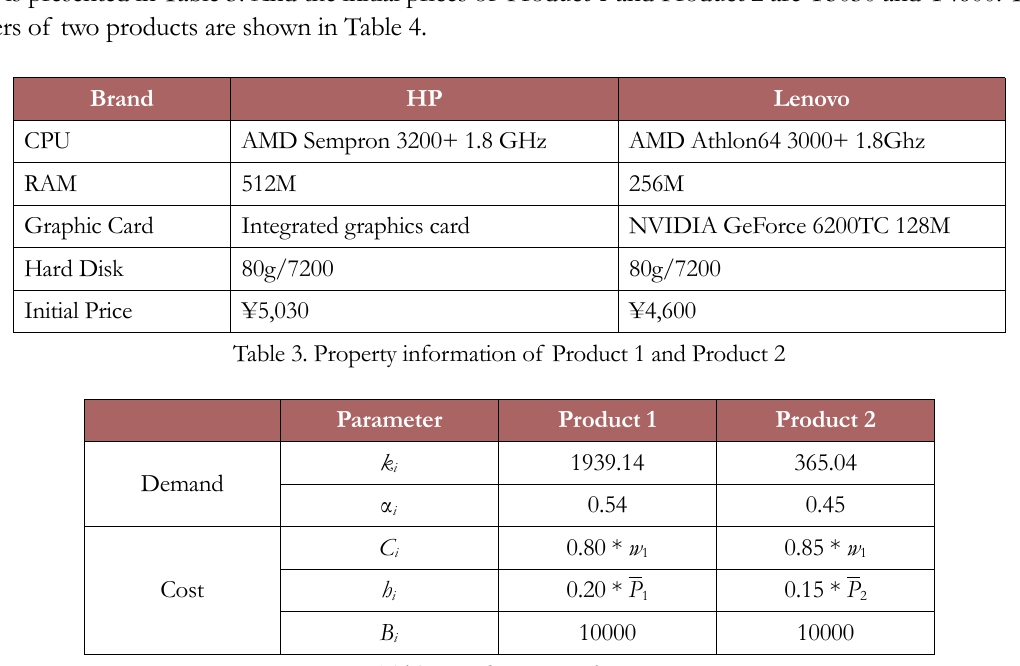
Table 4. Information